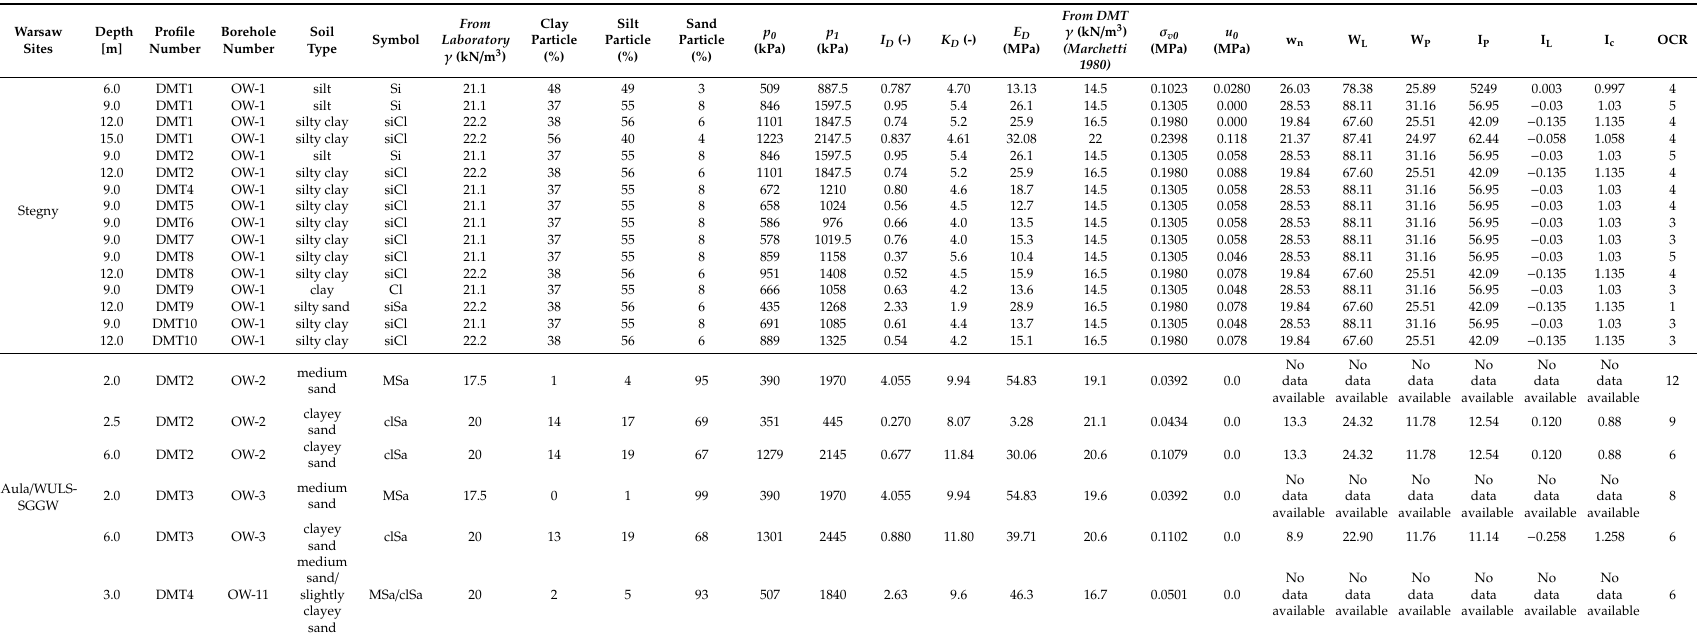
Table 2. List of DMT and borehole number (OW) test